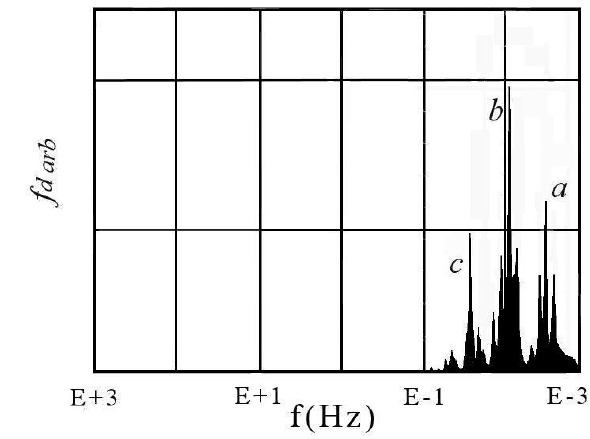
Figure 28. Power spectra and dominant frequency for Warburg impedance at equilibrium